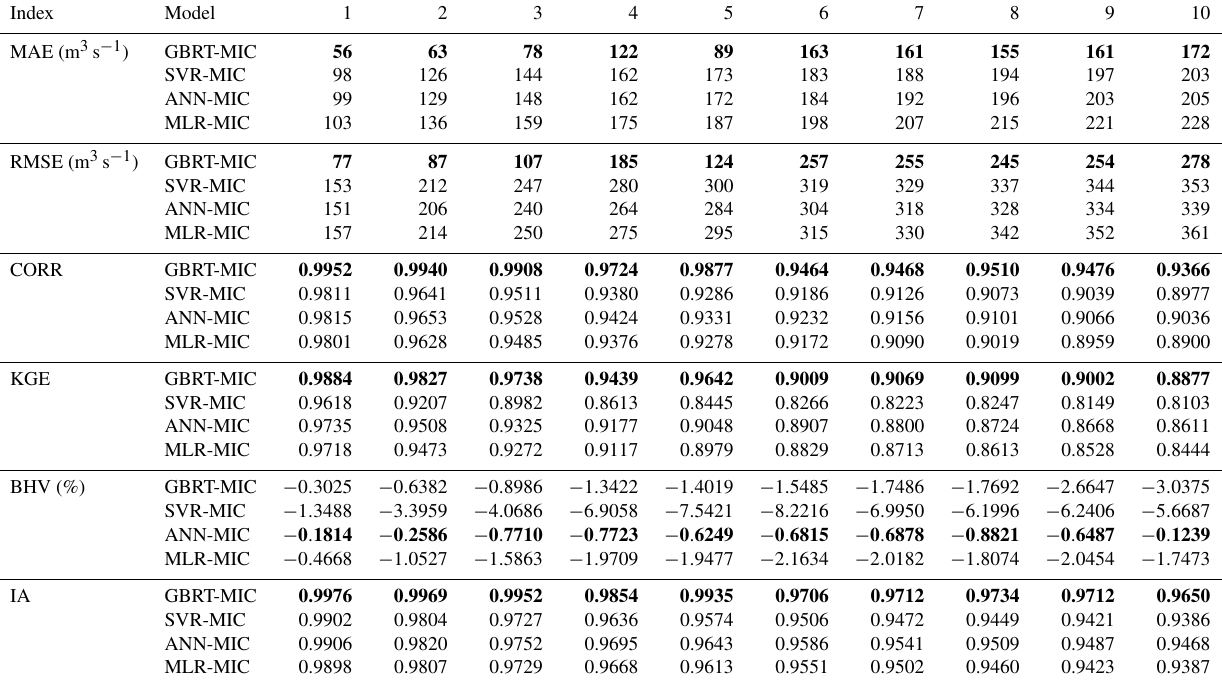
Table 7. Performance indices of the training